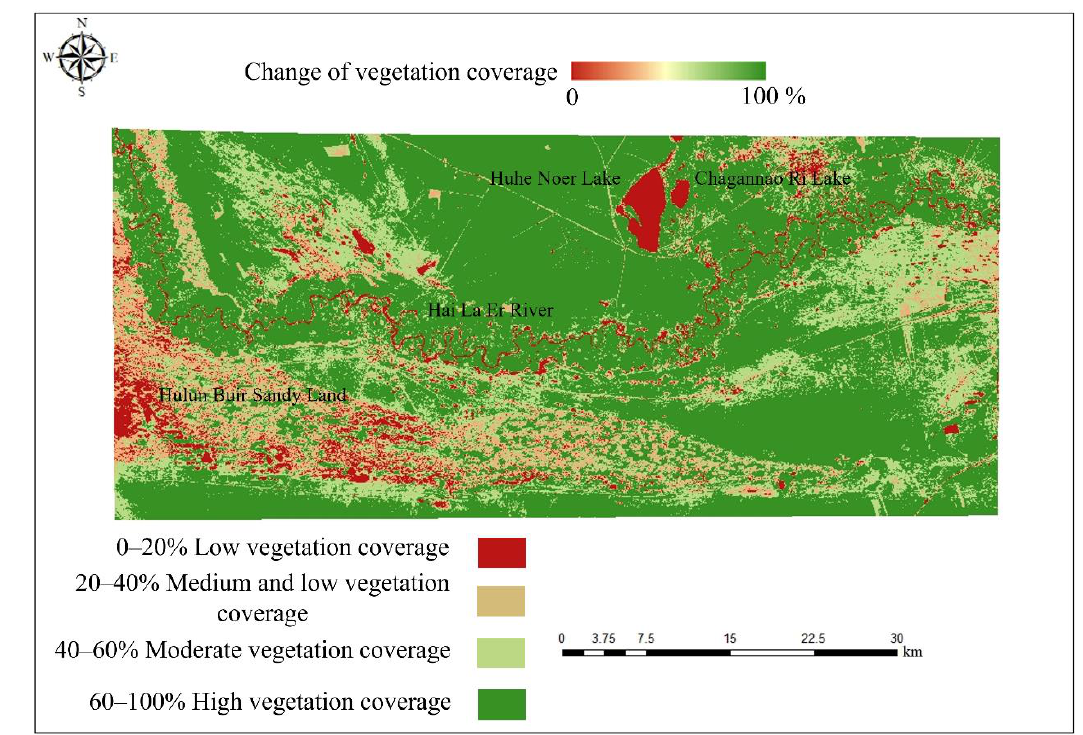
Figure 6. Vegetation coverage in the lower reaches of Hai La Er River in 2011.